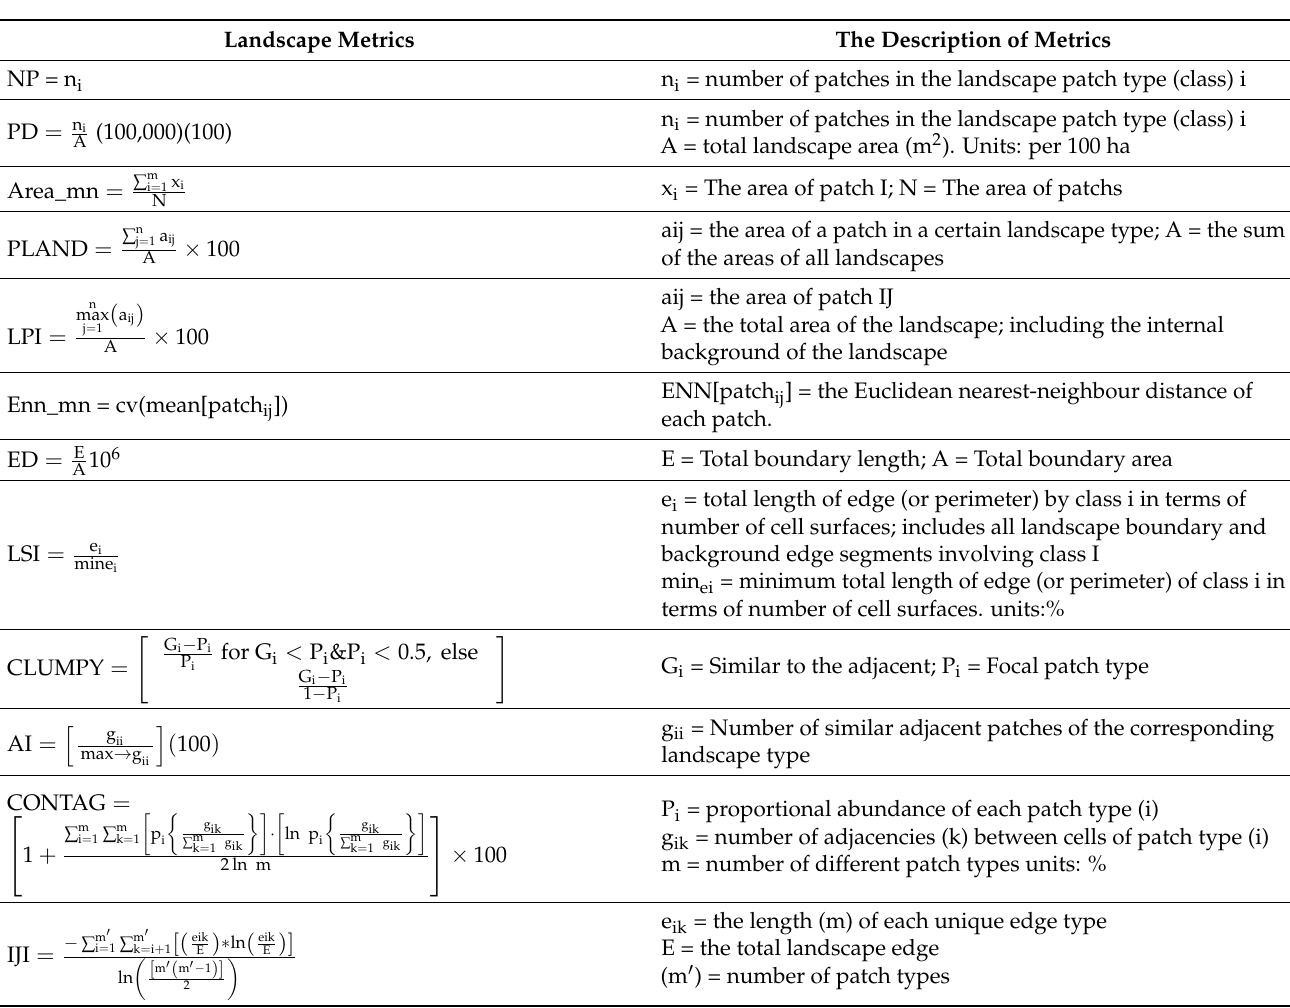
Table A3. Description of landscape pattern index. Landscape Metrics